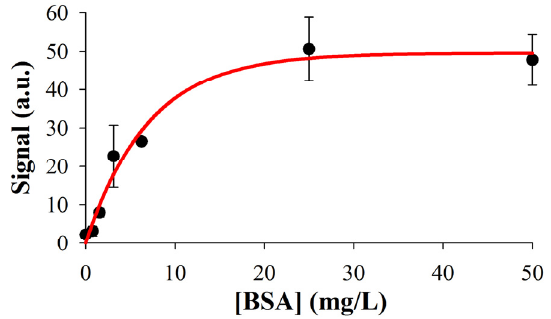
Figure 5. Results of the biorecognition assay model system for BSA detection on oxidized Al, measured by scanner fluorescence. Experimental data fit to an exponential rise to max curve ( R 2 =